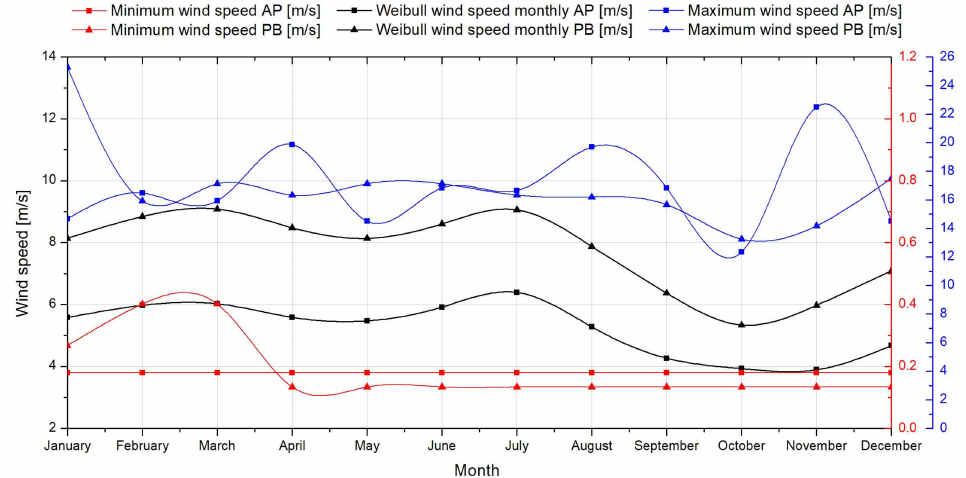
Figure 4. Wind speed graph for di ff erent measurement points in La Guajira